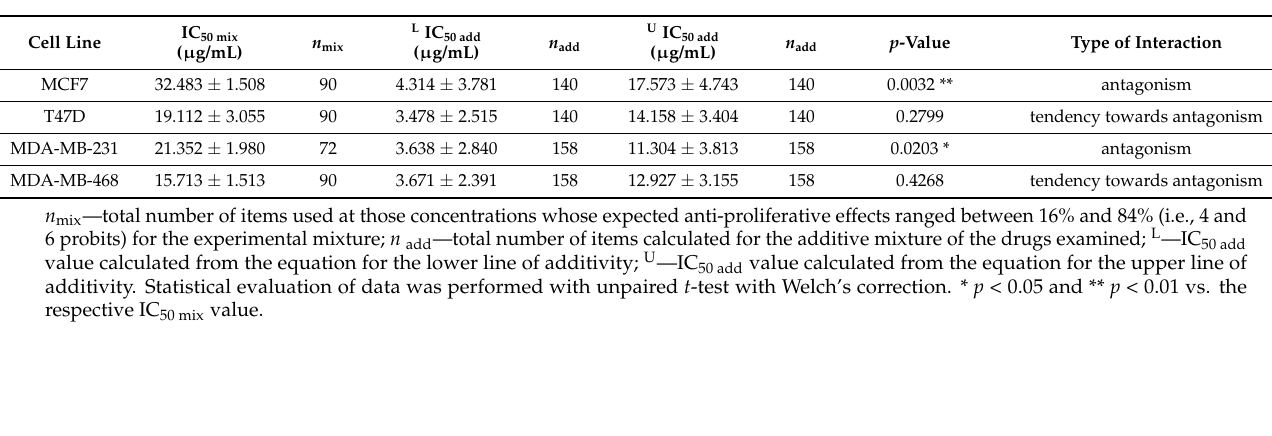
Table 2. Isobolographic interactions between CDDP and CAM at the fixed-ratio combination of 1:1 in four cancer cell lines (MCF7, T47D, MDA-MB-231, and MDA-MB-468) measured in vitro by the MTT assay. Results are presented as median inhibitory concentrations (IC 50 values in µ g/mL ± S.E.M.) for two-drug mixtures, determined either experimentally (IC 50 mix ) or theoretically calculated (IC 50 add ) from the equations of additivity [32,33], blocking proliferation in 50% of tested cells in four cancer cell lines (MCF7, T47D, MDA-MB-231, and MDA-MB-468) measured in vitro by the MTT assay. Cell Line IC 50mix ( µ g/mL) n mix